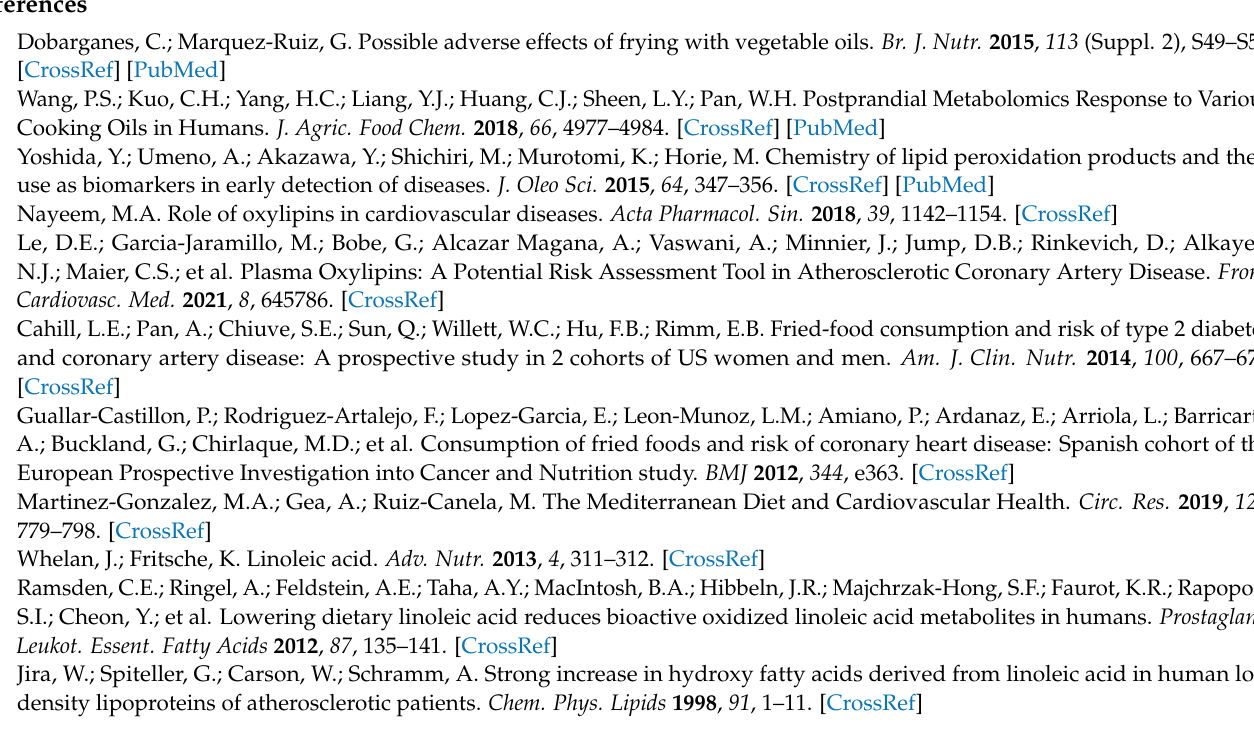
Figure S1: Boxplot of the four identified oxylipins (ppm). (0: control, 1: case). Figure S2: